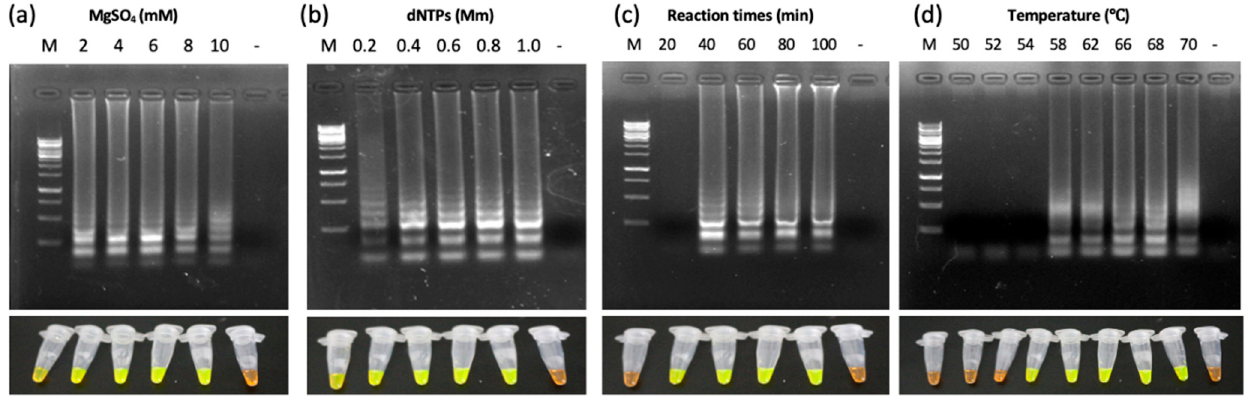
Figure 3. Optimization of LAMP reaction in detection of ChTBV1. ( a ) MgSO4 concentration; ( b ) dNTPs concentration; ( c ) reaction times; ( d ) reaction temperatures; (Lane M: GeneRuler 1 kb Plus DNA Ladder; lane -: negative control (sterile ddH 2 O)).